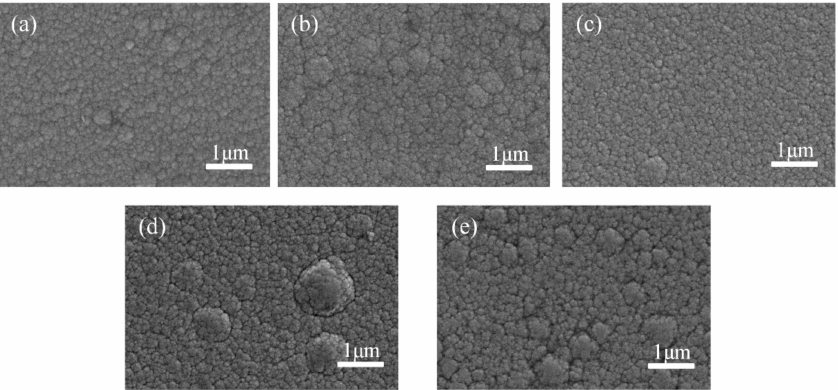
Figure 2. Surface FESEM micrographs of the composite coatings ( a ) 0.6 Pa, ( b ) 0.9 Pa, ( c ) 1.2 Pa, ( d ) 1.5 Pa, ( e ) 1.8 Pa.